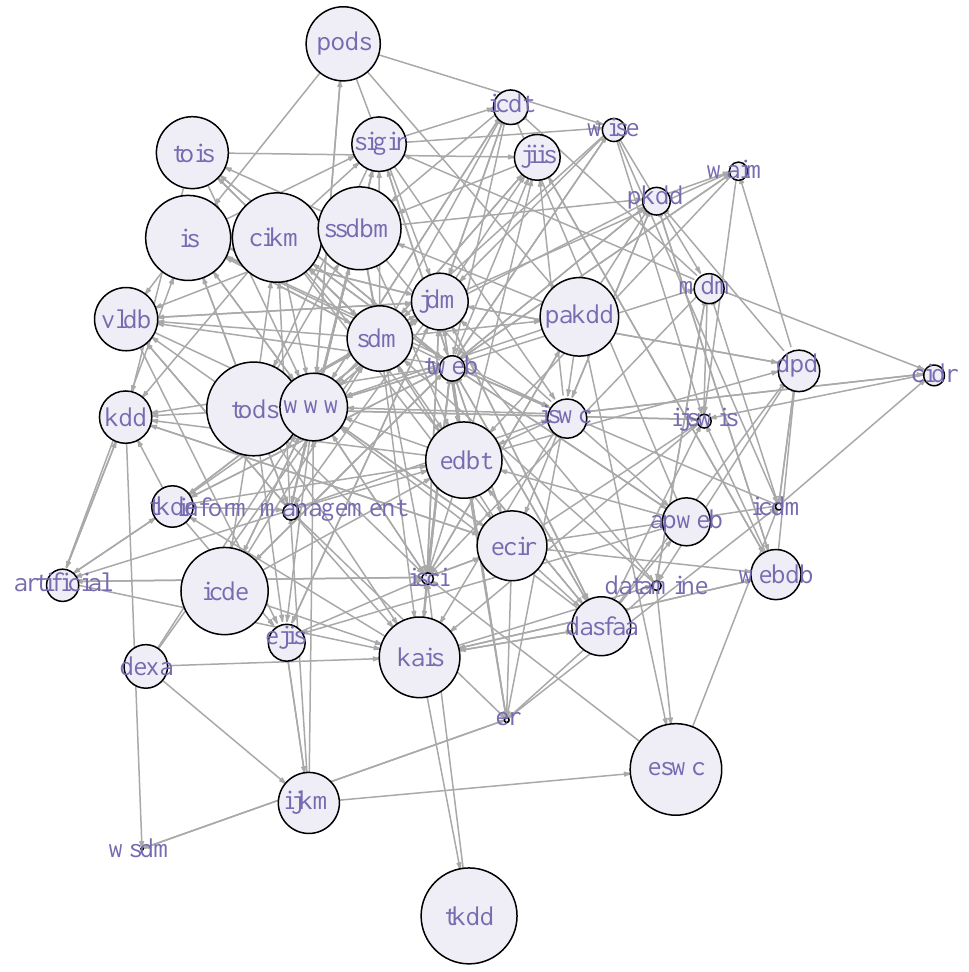
Figure 8. Influence dependency graph of DM conferences, using Reference Ratio and Unity priority function, where each edge represents pairwise Running Influence relation between conferences (Algorithm 2 using RR) for DM conference